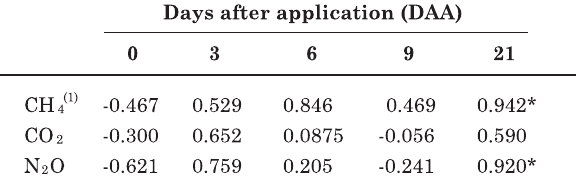
(1) Values used in correlations, expressed as average fluxes on each sampling day and average moisture percentage. * Significant at 5 %.